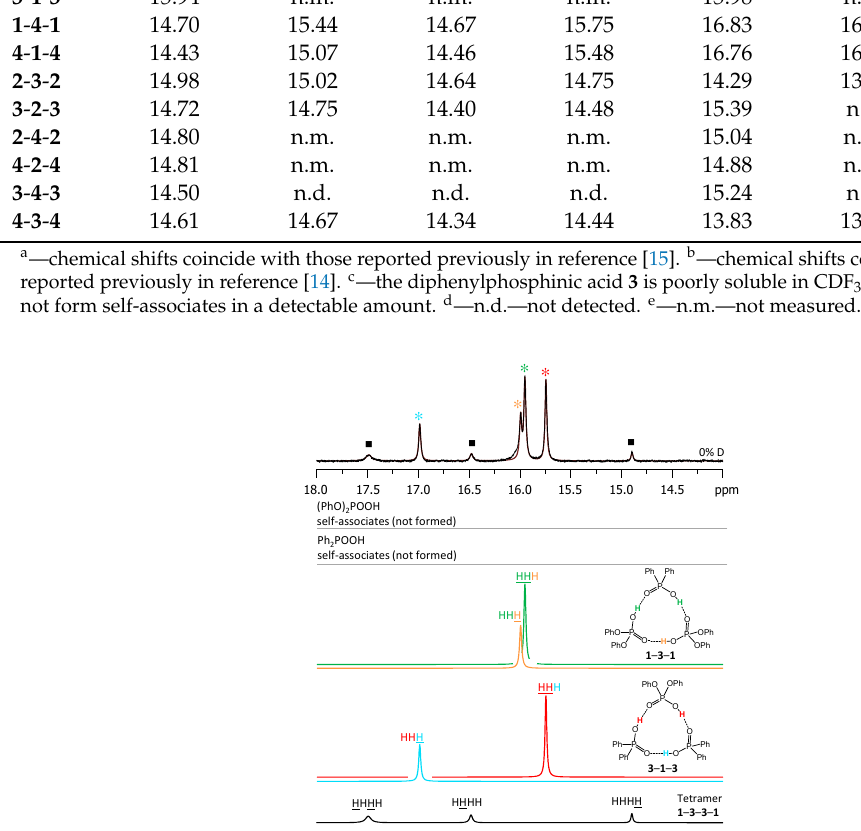
Figure 5. The low-field part of 1 H - NMR spectrum of the sample containing acids 1 and 3 (1.2:1) in CDF 3 /CDF 2 Cl at 100 K. The experimental spectrum is deconvoluted into the sub-spectra arising from self-associated of 1 or 3 , heterodimer 1 - 3 , two heterotrimers, 1 - 3 - 1 and 3 - 1 - 3 , and a tetramer, consisting of two molecules of 1 and two molecules of 3 in a cyclic 1 - 3 - 3 - 1 configuration. For visual clarification the signals in the experimental spectrum and the computed sub-spectra are color coded. Trimers and tetramers are marked by asterisks and squares, respectively.